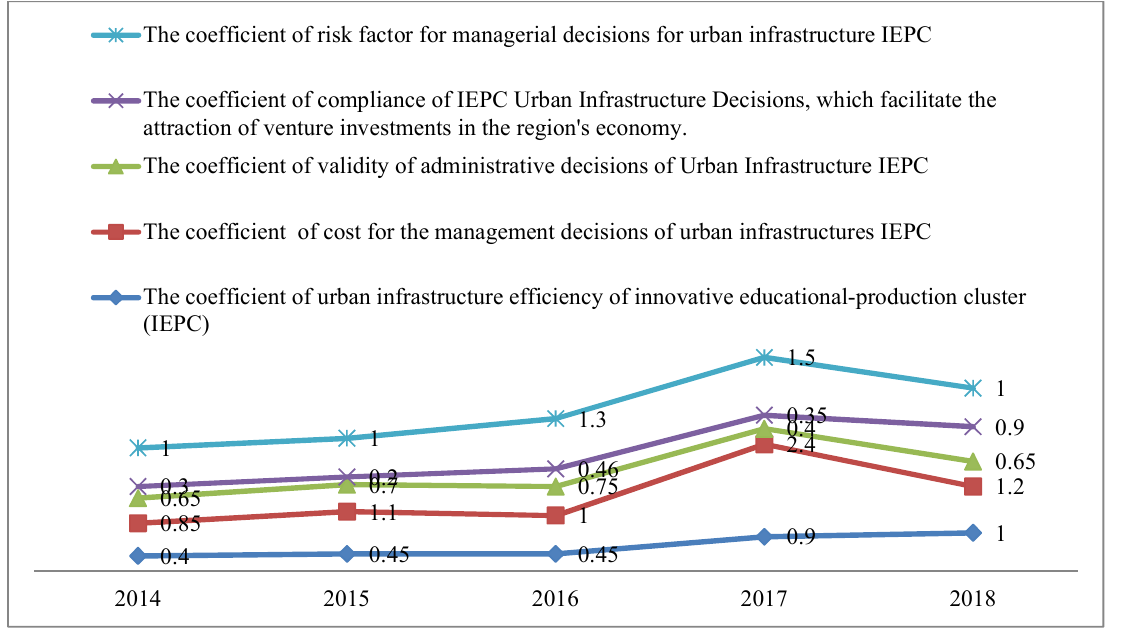
Fig. 5. The calculation of performance indicators for the functioning of the urban infrastructure of an innovative education and production cluster (IEPC).